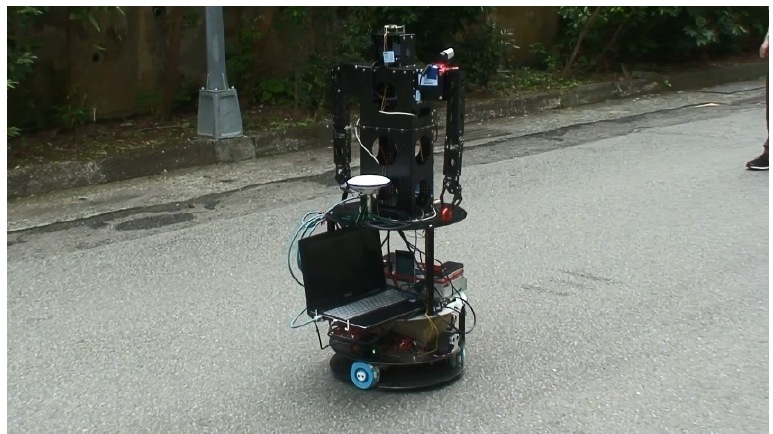
Figure 26. The robot patrolled towards the destination.